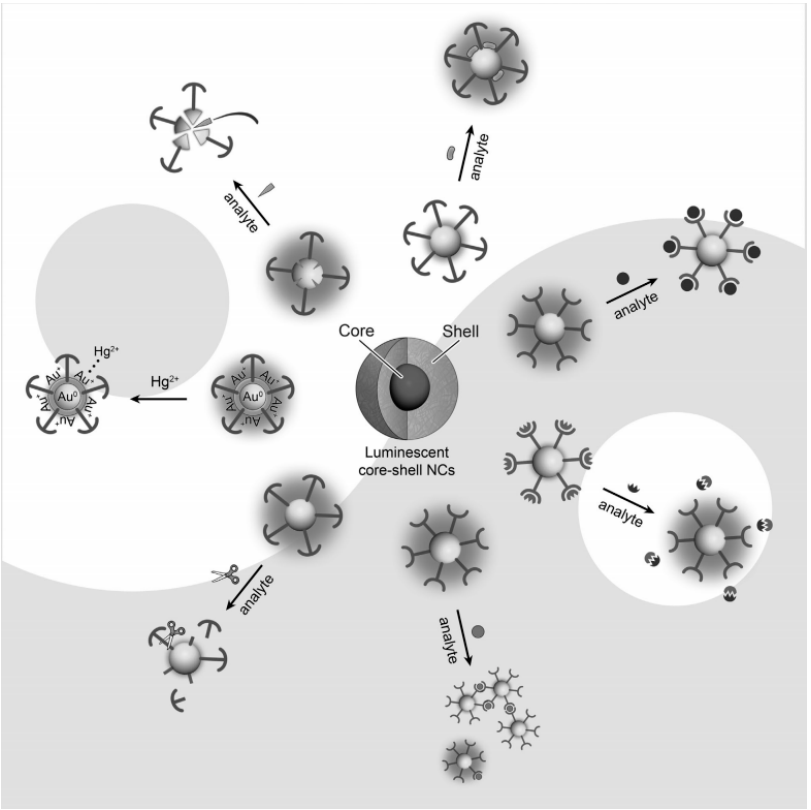
Figure 7. Response mechanisms of current noble metal NCs-based optical sensors. Reproduced with permission from [104]. Copyright Chemistry–An Asian Journal, 2013.